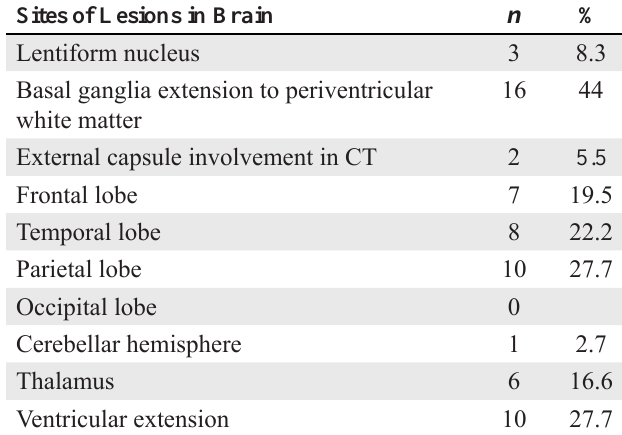
Table 2: Intracerebral hemorrhage sites of lesions in